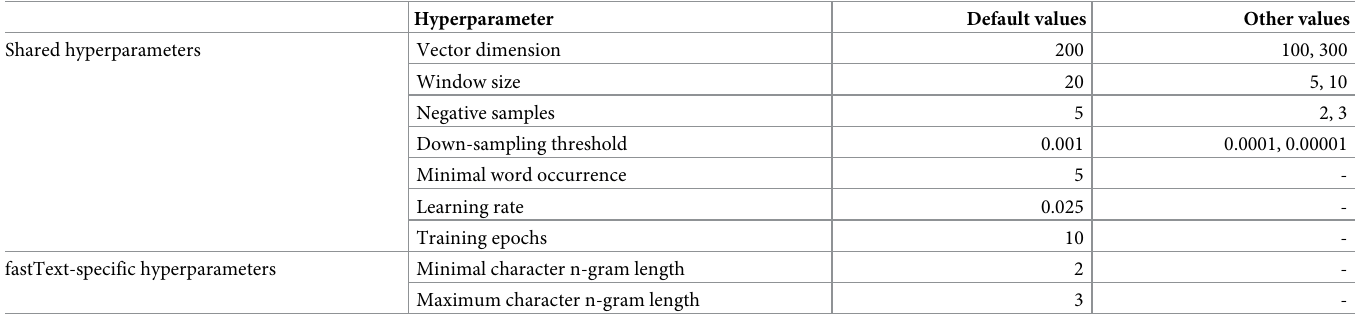
Table 2. The values of hyperparameters used for training BioConceptVec. Default values : the default values are identical to the values selected by baseline embeddings. We used the default values to train BioConceptVec (cbow), BioConceptVec (skip-gram), BioConceptVec (GloVe) and BioConceptVec (fastText). Other values : we also adopted other commonly-used hyperparameter values to test the effectiveness of BioConceptVec (cbow) under different parameter